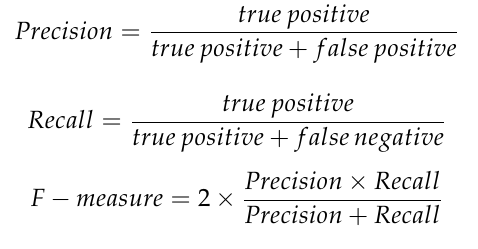
Supplementary Materials: The following are available online. Table S1: Percentages of overlaps between specific driver modules of different cancer types. Table S2. Percentages of overlapped genes between different cancer